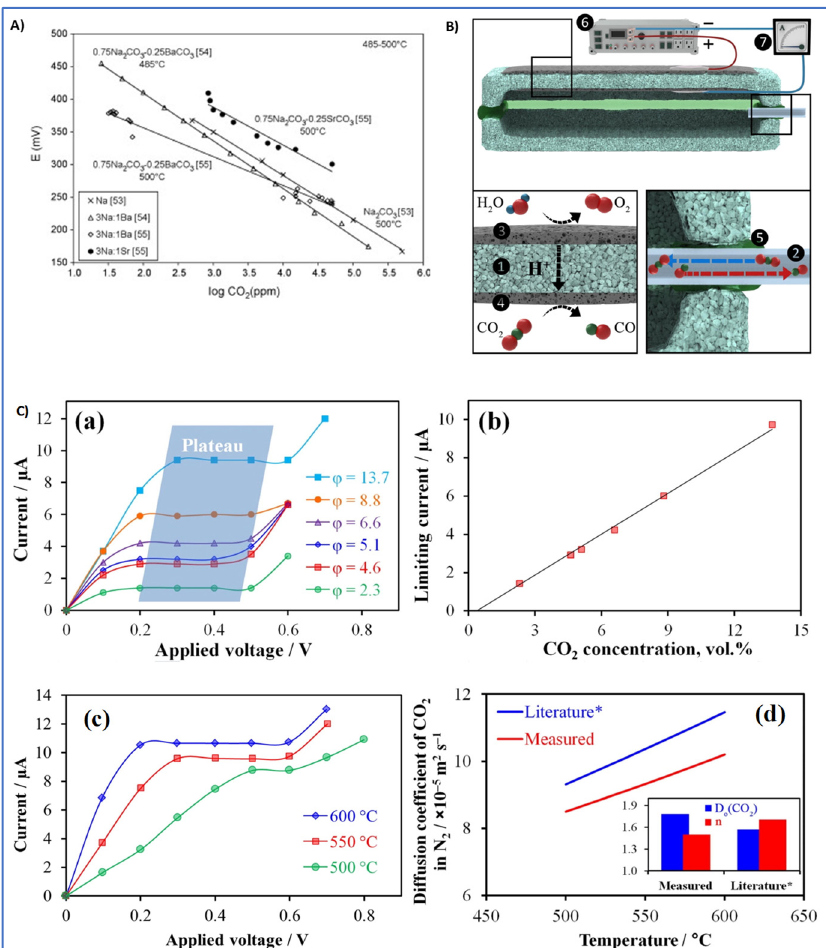
Figure 4. ( A ) Sodium ion-conducting electrolytes and different Na 2 CO 3 based auxiliary electrodes Reproduced with permission from [53]. ( B ) Configuration and operation of the amperometric CO 2 sensor; (1) La 0.9 Sr 0.1 YO 3- δ proton-conducting electrolytes; (2) capillary barrier; (3–4) Pt electrodes; (5) glass sealant; (6) DC source and (7) amperometer. Reproduced with permission from [54]. ( C ) ( a ) current–voltage curves for N 2 + 2%H 2 O + x%CO 2 (x = 2.3 to 13.7) gas mixtures, ( b ) relation between limiting current and CO 2 concentration, ( c ) current–voltage curves for N 2 + 2%H 2 O + 13.7%CO 2 for 500, 550, and 600 °C, and ( d ) experimental D CO2 values for different temperatures compared to the values from literature. Reproduced with permission from [54].